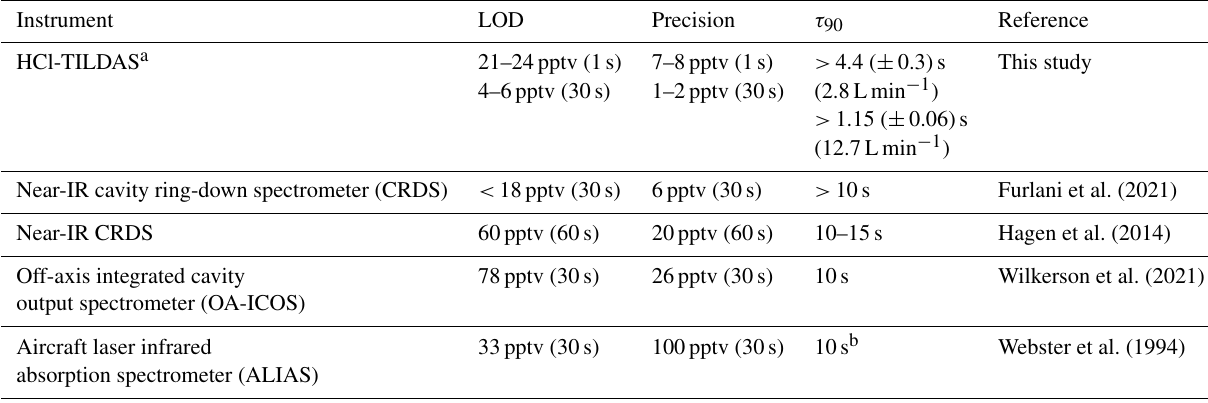
Table 1. Summary table comparing the performance of HCl TILDAS to similar previously reported optical methods.